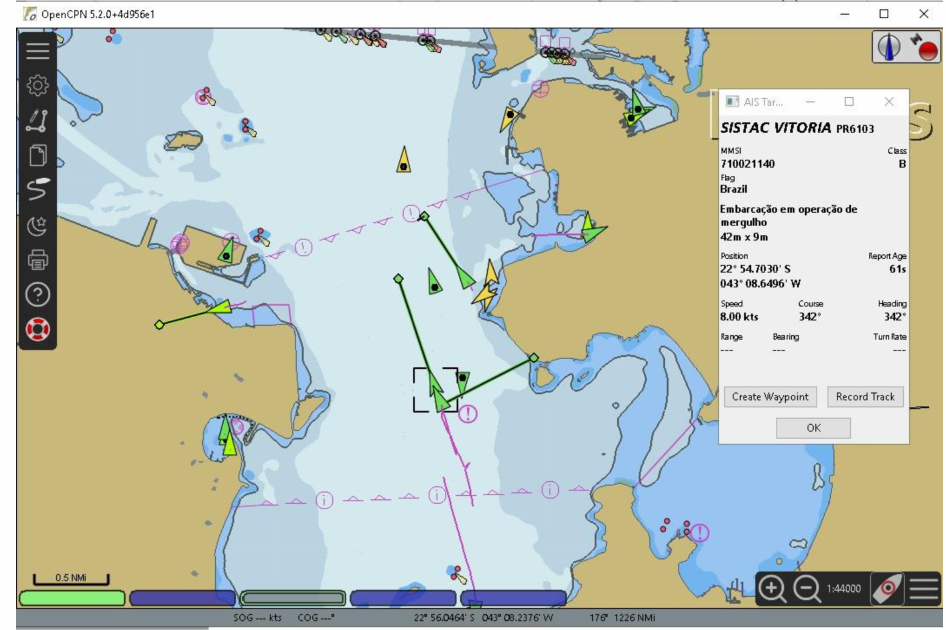
Figure 5. Example of a typical ECDIS screen displaying received AIS